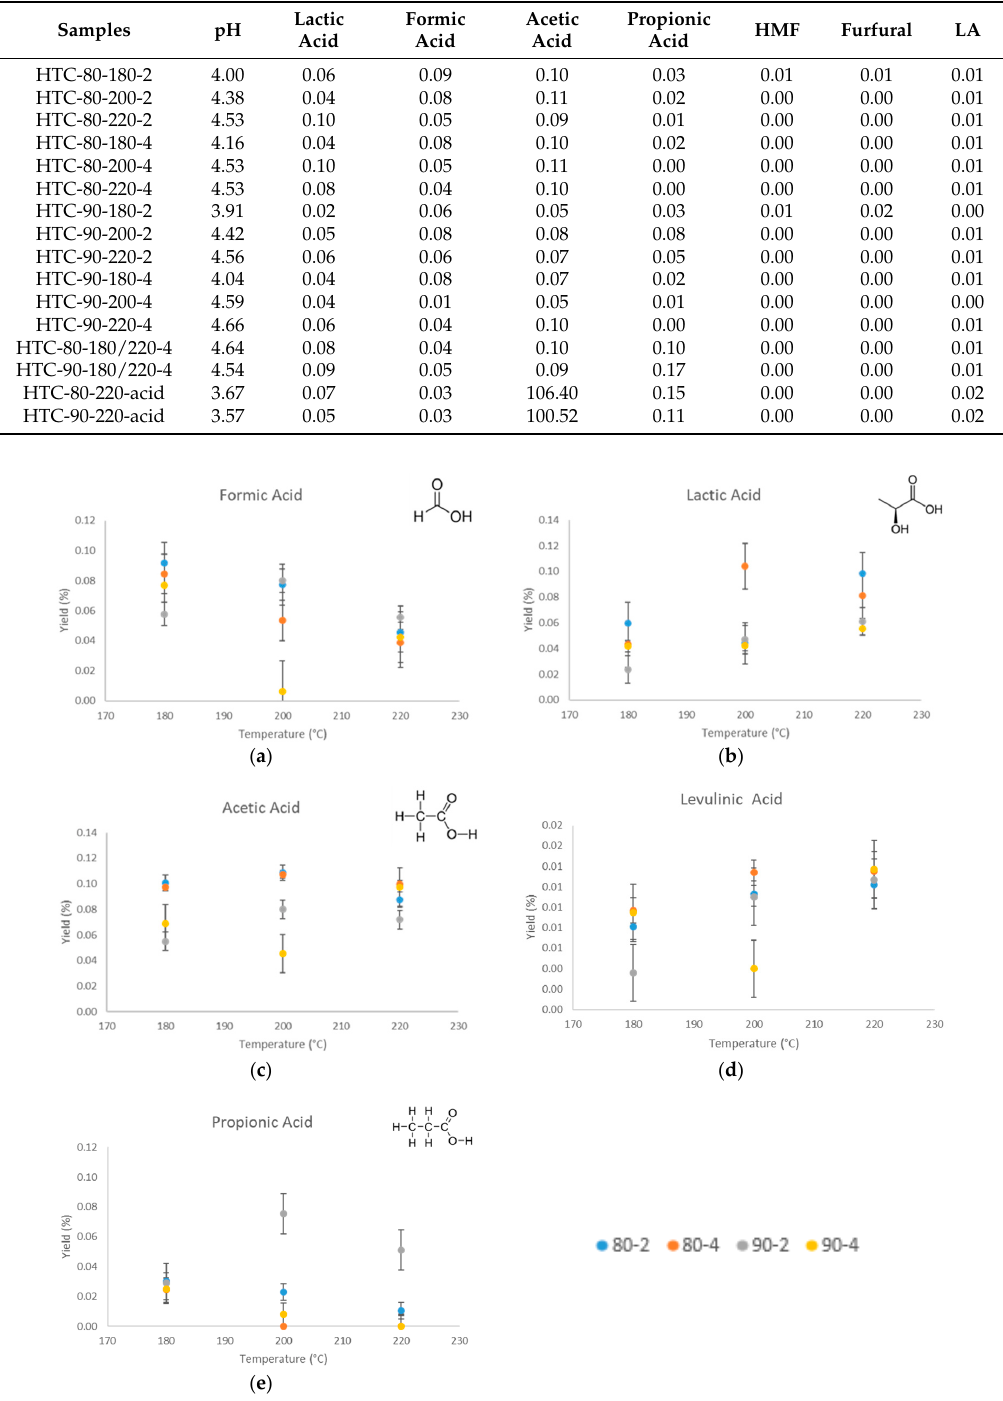
Table 5. pH and dissolved organic chemical yield in liquid fraction at different process conditions. HMF: 5-hydroxymethylfurfural and LA: levulinic acid. Samples